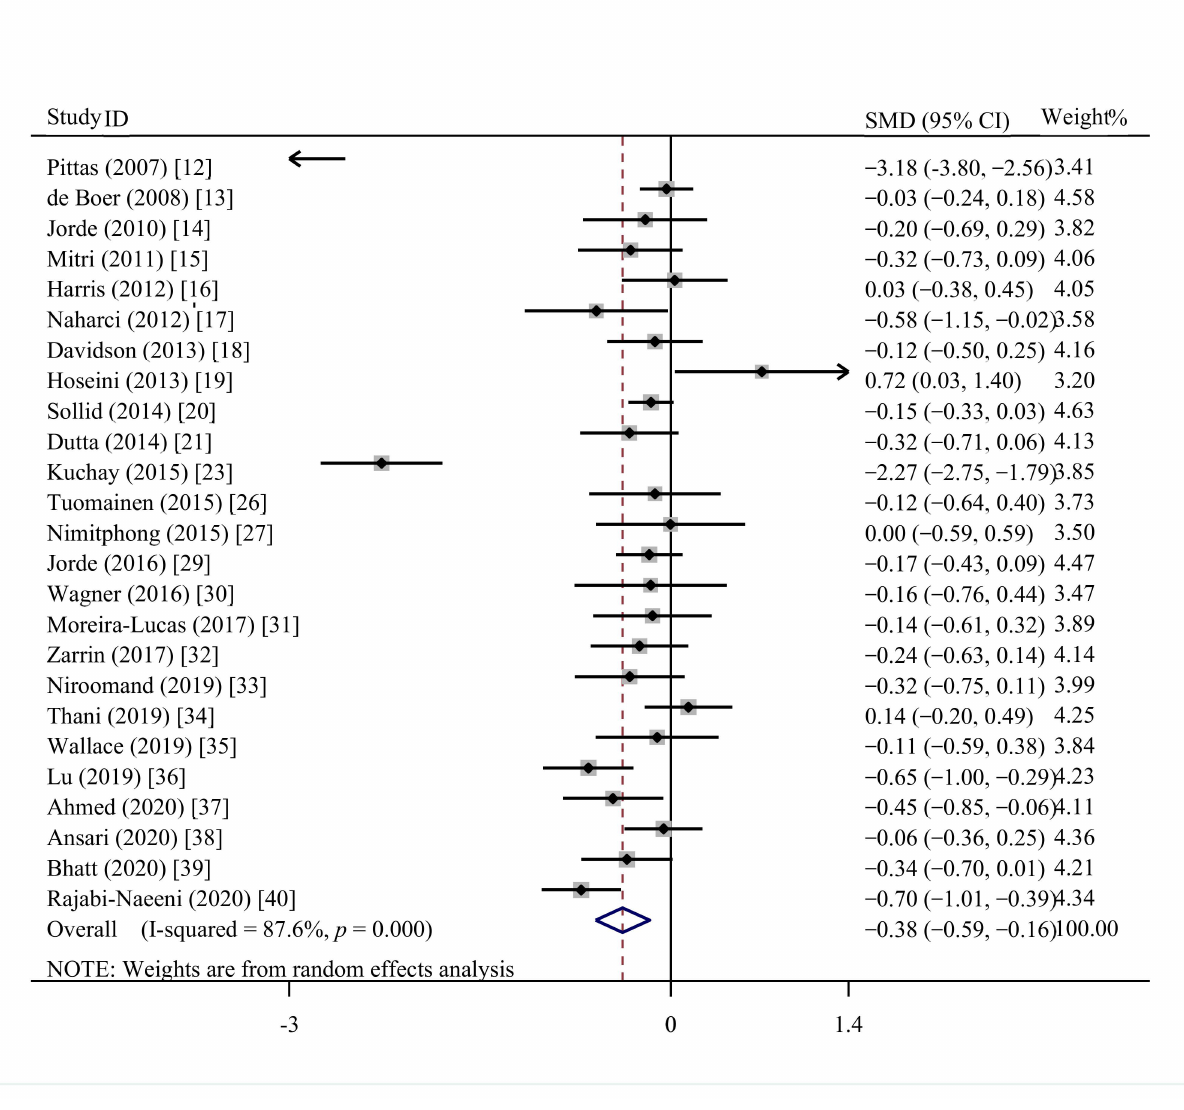
Figure 2. Effect of vitamin D supplementation on fasting blood glucose in